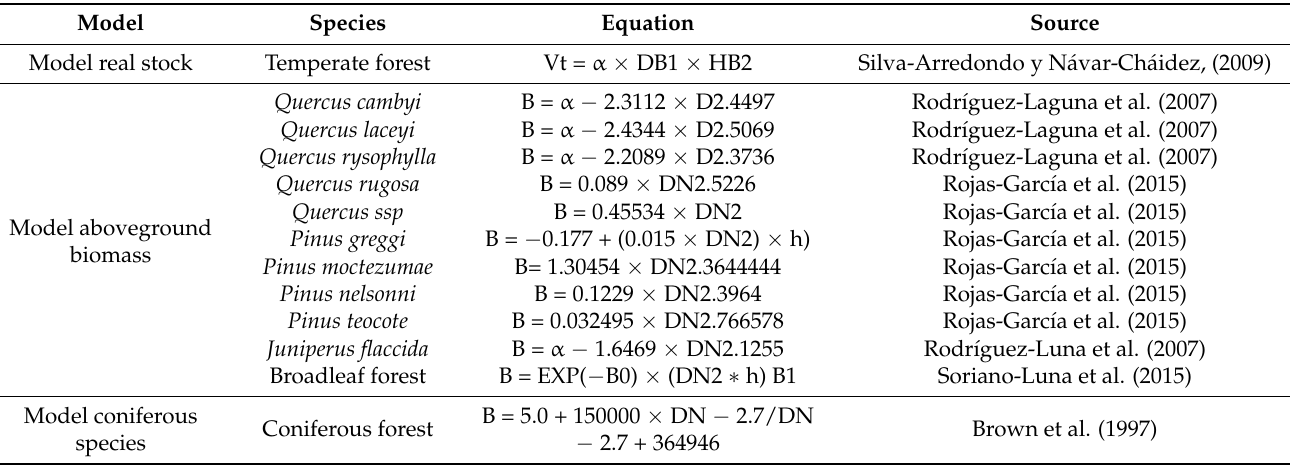
Table 1. Equations of three models used to estimate fuel load.